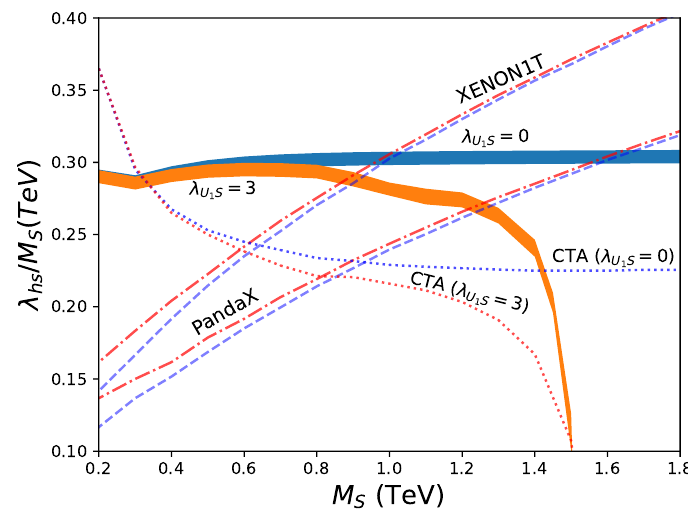
Figure 5 . Values of λ hS /M S (TeV) required to reproduce the relic density (within ± 3 σ ) as a function of M , for λ = 0 (blue band) and λ = 3 . 0 (orange band). Dashed lines show S U 1 S U 1 S present constraints from the upper limit on the spin-independent cross section σ Sp [64] for the SI SSDMM (blue) and the SSDMM + U (orange). Dotted lines indicate the future limits from 1 indirect detection searches by CTA